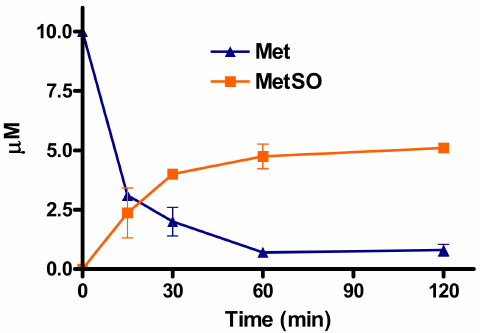
Figure 5. Oxidation of free L-methionine by carbonate radical anion. 10 µ M L-methionine was incubated at 37 ◦ C with 31 µ M SOD, 25 mM sodium bicarbonate, 0.1 mM DTPA in 0.1 M phosphate bu ff er, pH 7.4. Reaction was started by the addition of 1 mM H 2 O 2 . At various time intervals, the reaction was stopped by addition of catalase (400 U / mL) and the reaction products analyzed by